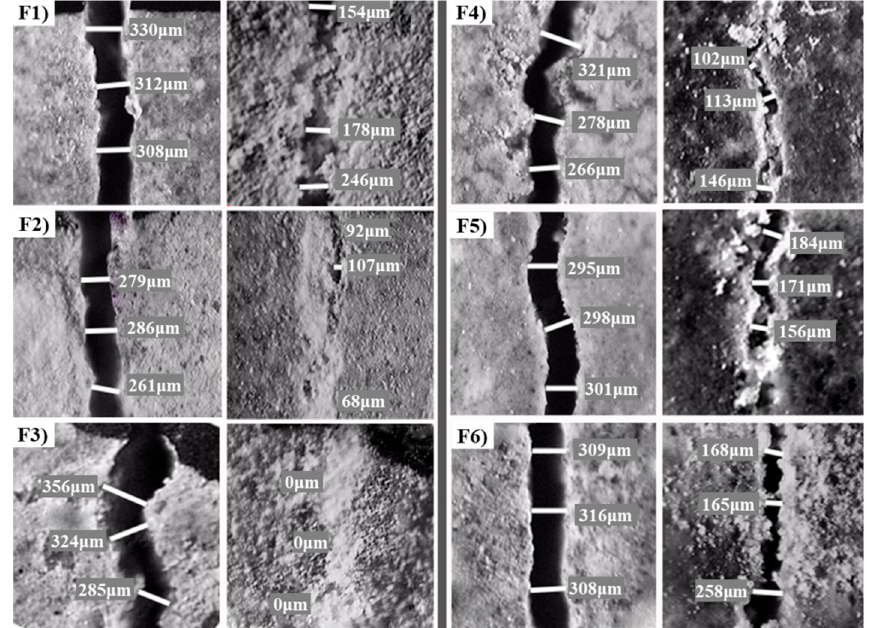
Figure 3. Optical micrographs of cracks closure (The left pictures show the crack before self-healing and the right ones show them after self-healing for each group; ( F1 – F6 ) are the group numbers of cement particles with the average size 22.82 µ m, 29.78 µ m, 39.10 µ m 49.96 µ m, 60.51 µ m and 73.60 µ m, respectively.)